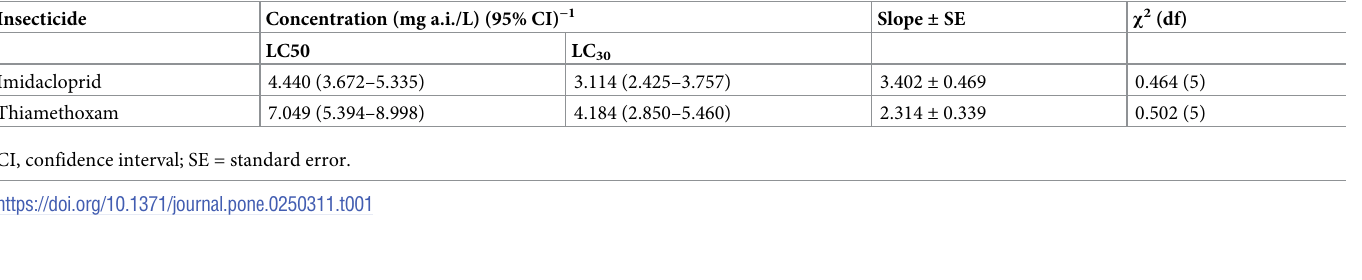
Table 1. Toxic effects of imidacloprid and thiamethoxam on the first instar nymphs of A . glycines . Insecticide